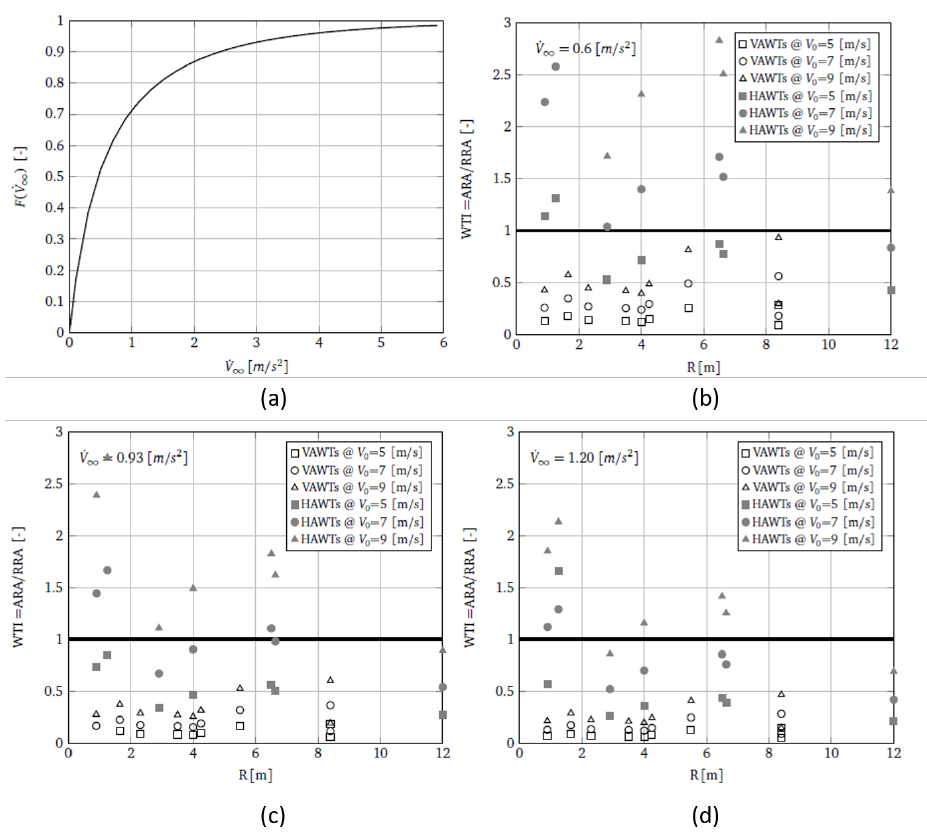
Figure 3. Cumulative gust probability of urban sites ( a ) and WTI as a function of the rotor radius, and three typical wind acceleration rates for some commercial HAWTs and H-type Darrieus VAWTs ( b ) ˙ V ∞ = 0.6 [m/s 2 ], ( c ) ˙ V ∞ = 0.9 [m/s 2 ], ( d ) ˙ V ∞ = 1.20 [m/s 2 ]), for different initial wind speeds V 0 = 5 [m/s], V 0 = 8 [m/s], V 0 = 9